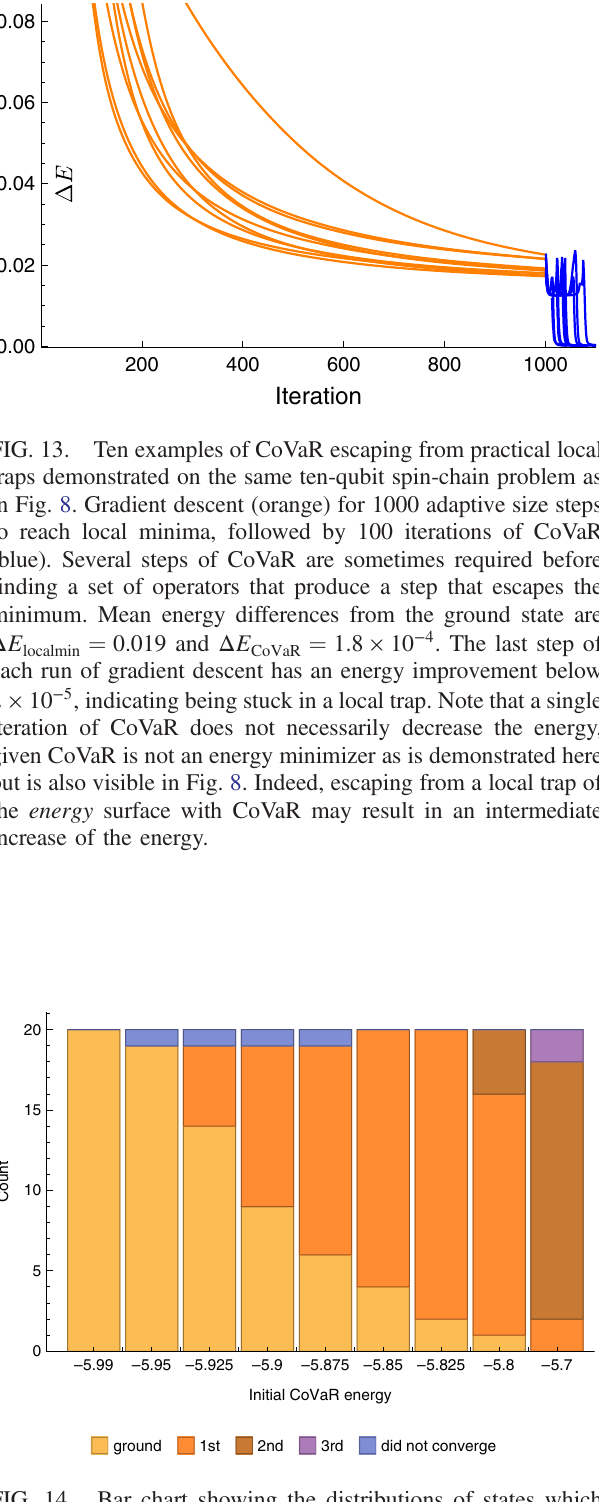
FIG. 14. Bar chart showing the distributions of states which CoVaR converges to for the runs in Fig. 9 showing the probability of converging to the ground state with initial overlap (conver- gence being an energy difference of less than 10 − 3 in this case) as a function of its initialization energy. Each bar corresponds to one point in Fig. 9, but there are two additional points on the right of the